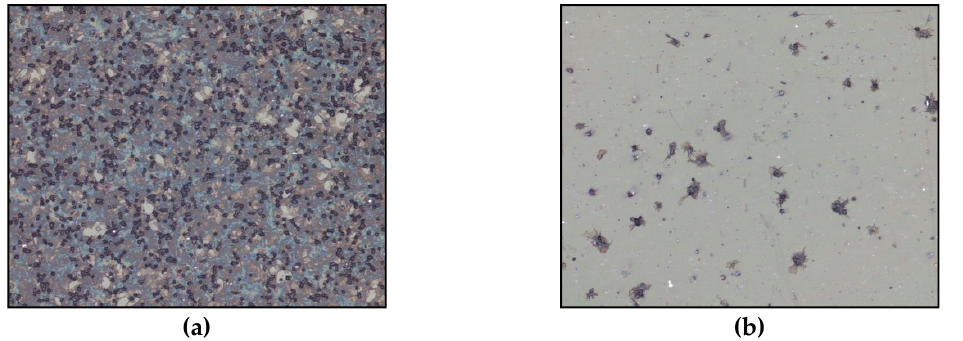
Figure 4. Platelet adhesion on untreated ( a ) and oxygen plasma treated ( b ) poly(ethylene terephthalate (PET) polymer. Incubation was performed with shaking at 250 RPM.